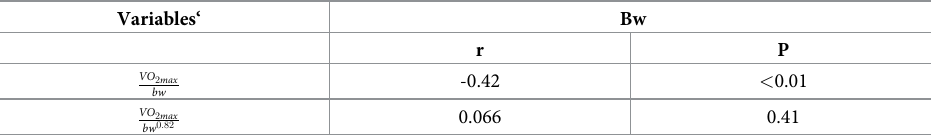
Table 4. Pearson Correlation Coefficient of the relationship between VO 2 max Variables‘ Bw VO 2 max bw VO 2 max bw 0 : 82 There is a significant moderately strong negative relationship in VO 2 max correlation has shown in VO 2 max and bw (r = -0.066, p = bw 0 : 82